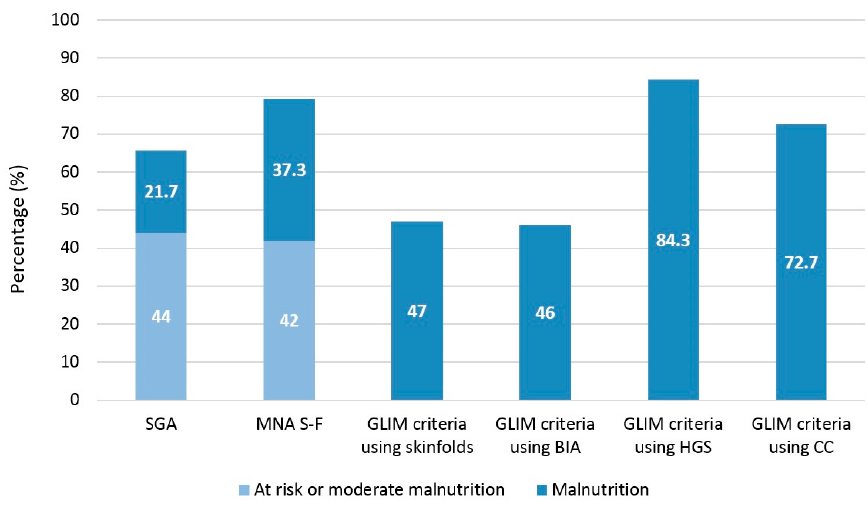
Figure 2. Malnutrition diagnosis according to the tool used. SGA: Subjective Global Assessment; MNA S-F: Mini Nutritional Assessment Short Form; GLIM: Global Leadership on Malnutrition; BIA: Bioelectrical impedance analysis; HGS: Handgrip Strength; CC: calf circumference.